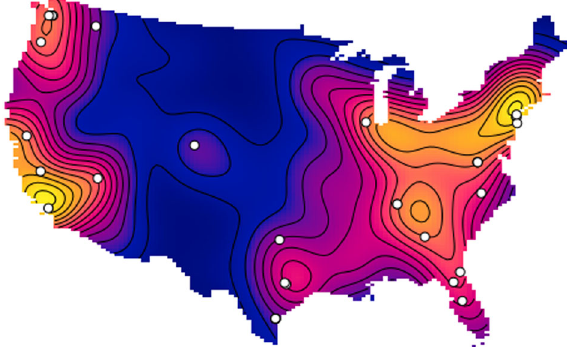
Fig. 3 The total intensity (in black), as well as the isolated endemic component (grey), over time. Total intensity can be interpreted as the proportion of radicalization probability that is explained by the endemic and epidemic components.